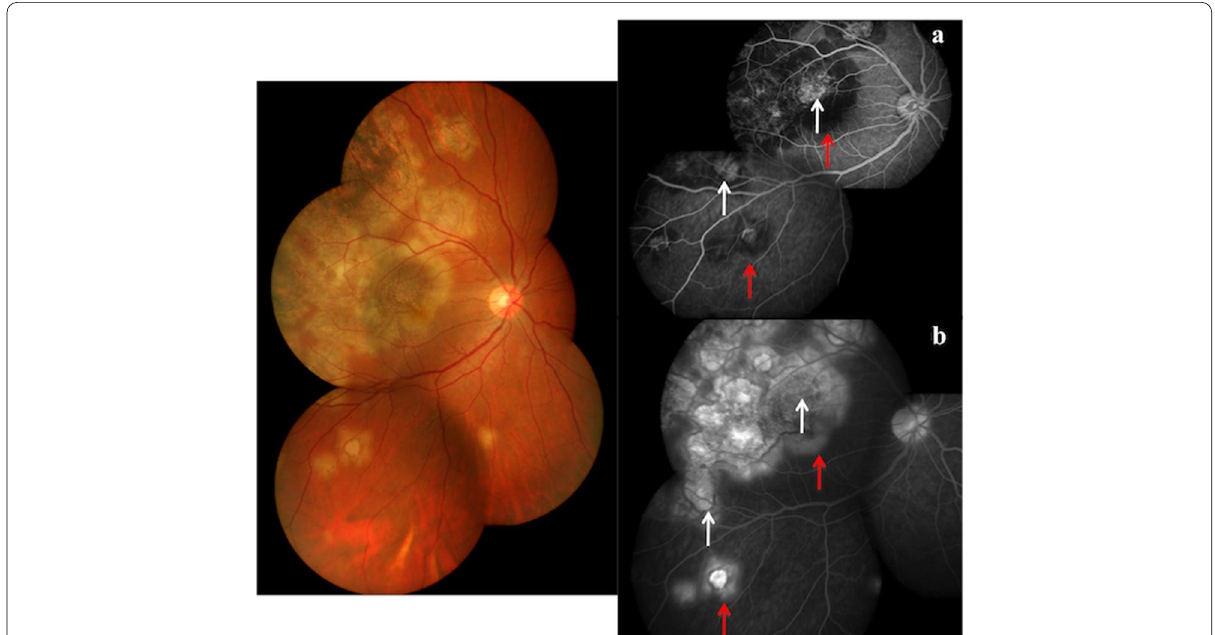
Fig. 2 Color fundus photograph showing active lesions of TB SLC (left panel). Fluorescein angiography in early phase a showing transmission hyperfluorescence in the centre of lesions (white arrows) corresponding to healed lesions and hypofluorescence along the border of lesions (red arrows) corresponding to active lesions. The late phase b shows transmission hyperfluorescence persisting in the centre of lesions (white arrows) corresponding to healed lesions and hyperfluorescence along the border of lesions (red arrows) corresponding to active